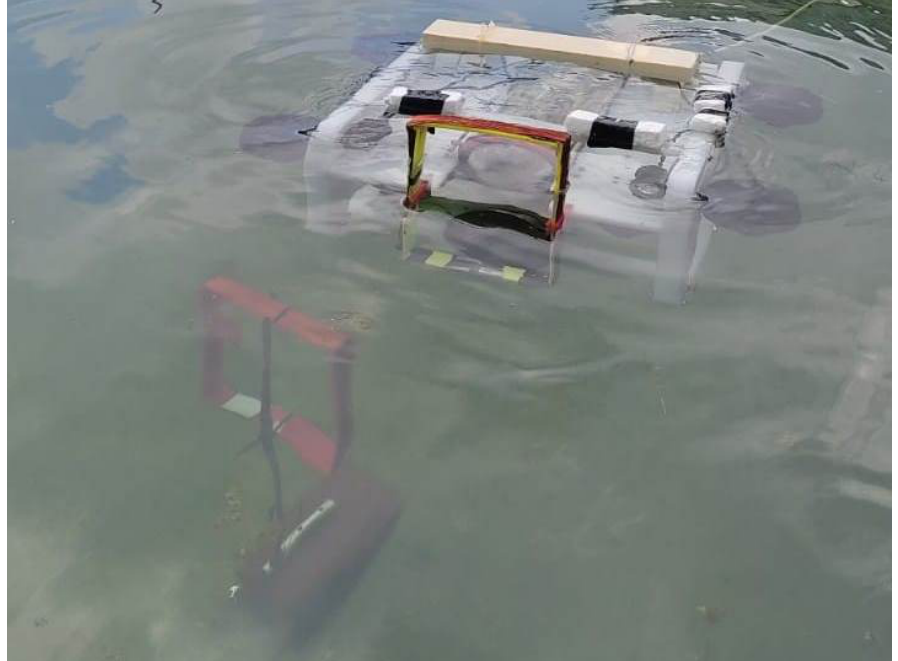
Figure 13. Data transmission in water with